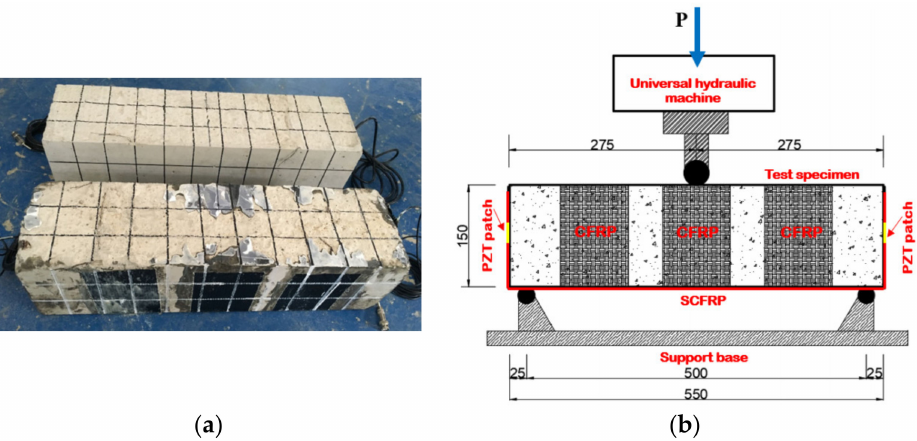
Figure 24. ( a ) Concrete beams with and without CFRP strengthening; ( b ) detailed loading setup. Reproduced with permission from [74], MDPI,